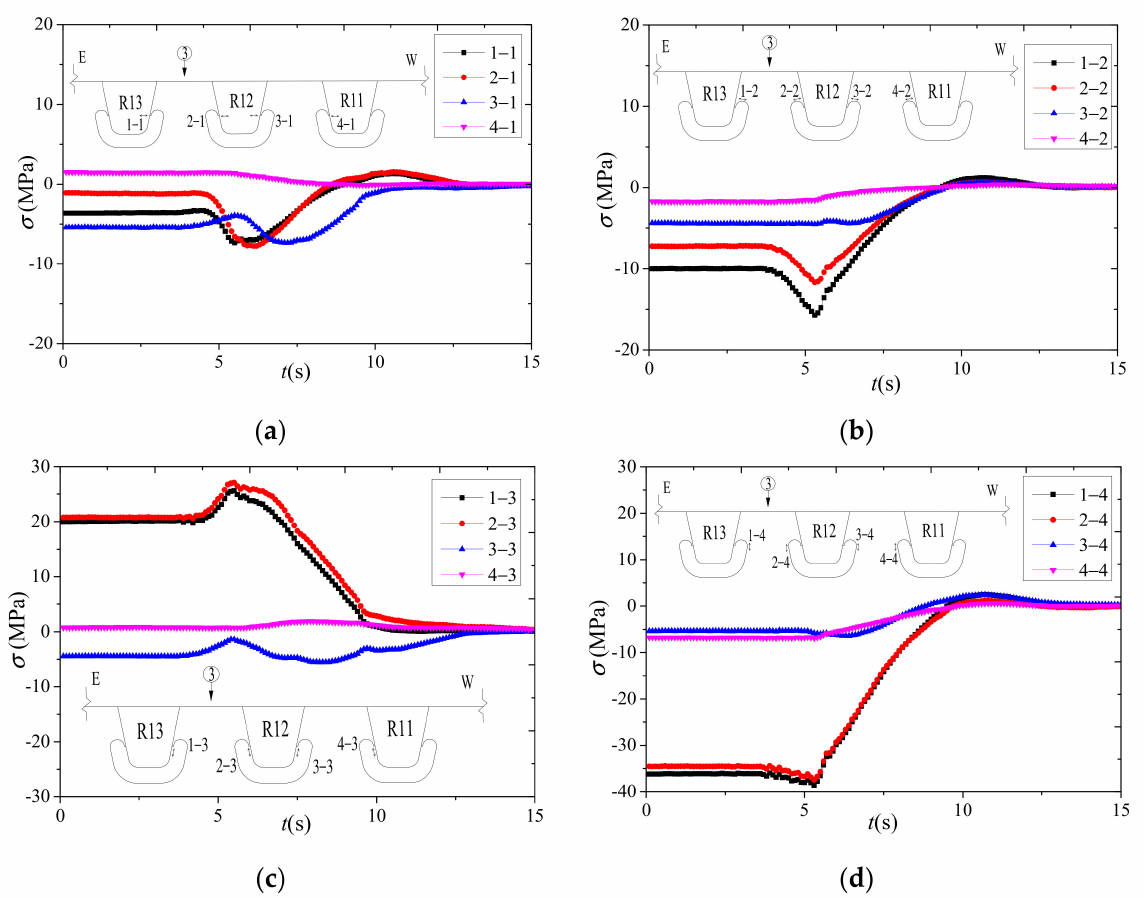
Figure 9. Stress records under LC3. ( a ) RF-R; ( b ) RF-F; ( c ) RF-W; ( d )